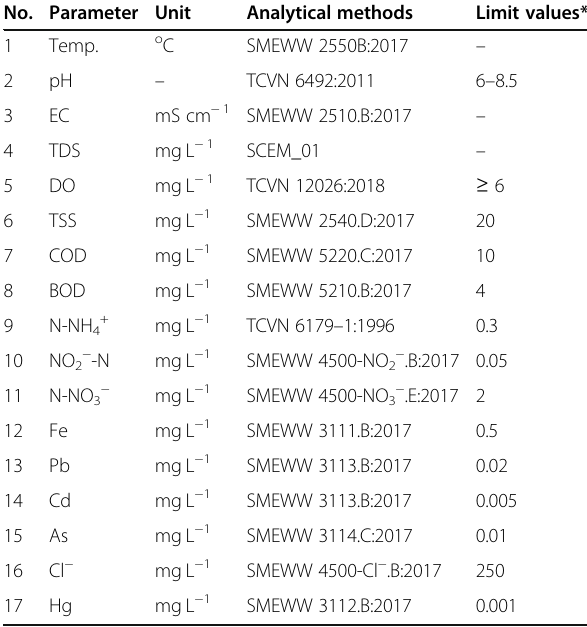
Table 1 Methods for water analysis and limit